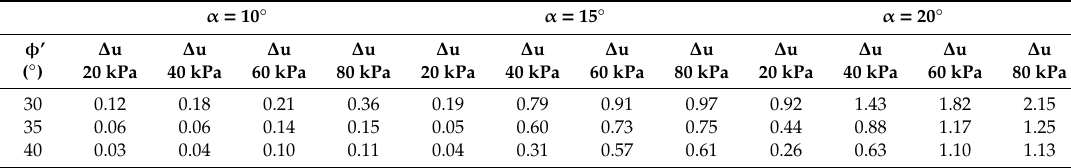
Figure 14. Dimensionless run-out distance, R / H, versus φ ’, for ∆ u = 60 kPa and some values of α . Table 2. Values of the dimensionless run-out, R / H, calculated using the MPM. φ ’: shearing resistance angle; α : inclination angle; ∆ u: excess pore water pressure. α = 10° α = 15° α = 20°